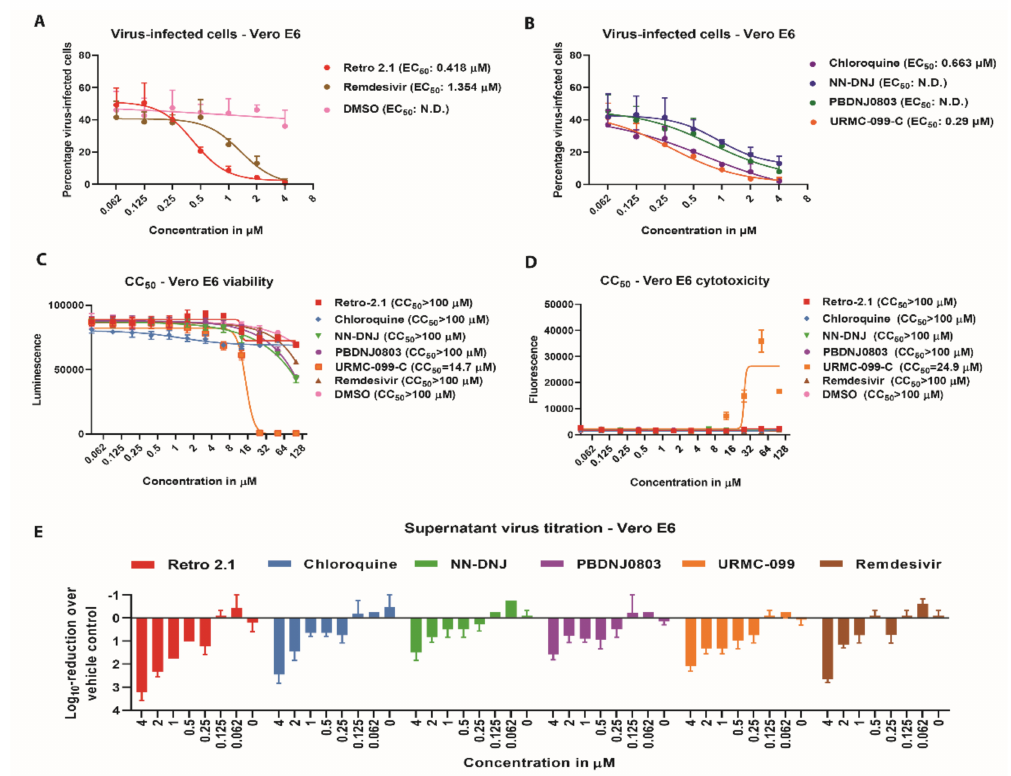
Figure 3. Half maximal e ff ective concentration (EC 50 ) determination of the five hit compounds showing inhibition against SARS-CoV-2. Vero E6 cells were pre-treated for 2 h with the indicated compound concentrations prior to SARS-CoV-2 infection (MOI 0.01) at 37 ◦ C in a humidified incubator with 5% CO 2 . Following infection, cells were fixed and processed for immunofluorescence analysis. To determine the reduction in the percentage of virus-infected cells, the number of cells with a green fluorescent protein (GFP)-positive cytoplasmic signal (infected cells) was divided by the total number of cells (DAPI, nuclei). The percentage of virus-infected cells of Retro-2.1 was compared to remdesivir, DMSO ( A ) and chloroquine, n -nonyldeoxynojirimycin (NN-DNJ), PBDNJ0803 and URMC-099 ( B ). Abbreviations: N.D.: not determined. Results are displayed as means and SD of three independent experiments. The results of the half-maximum cytotoxicity concentration (CC 50 ) based on